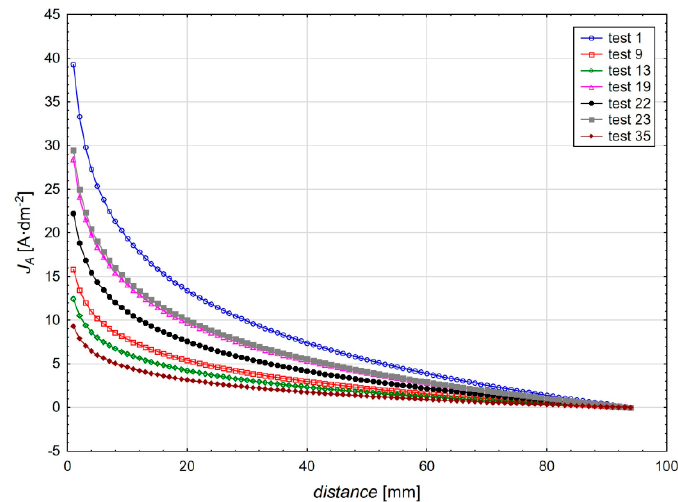
Figure 3. Distribution of current densities in samples in the selected experiments.